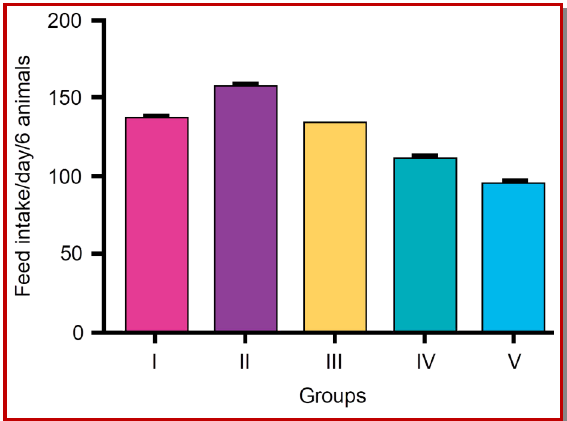
Figure 2: Body temperature of animals post-treatment